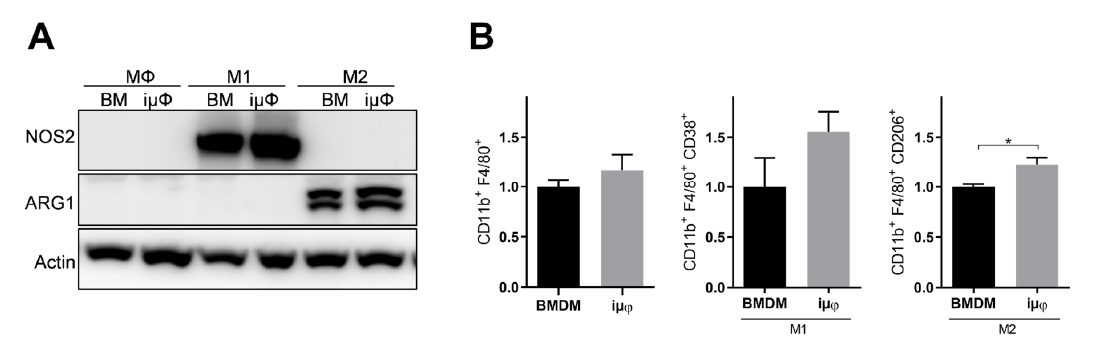
Figure 3. NOS2 and ARG1 protein levels and CD11b + cell population are similar in M1 and M2 stimulated i µ Φ and BMDM macrophages. ( A ) Representative blot images of NOS2 and ARG1 proteins expression in resting (M Φ )-, M1- and M2-stimulated i µ Φ or BMDM macrophages ( n = 3). ( B ) Flow cytometry cell analysis of CD11b + CD38 + cell population in M1-stimulated i µ Φ and BMDM macrophages and for CD11b + CD206 + cell population in M2-stimulated i µ Φ and BMDM macrophages. Data are means ± SEM. * p < 0.05. Original blot images were presented in Figure